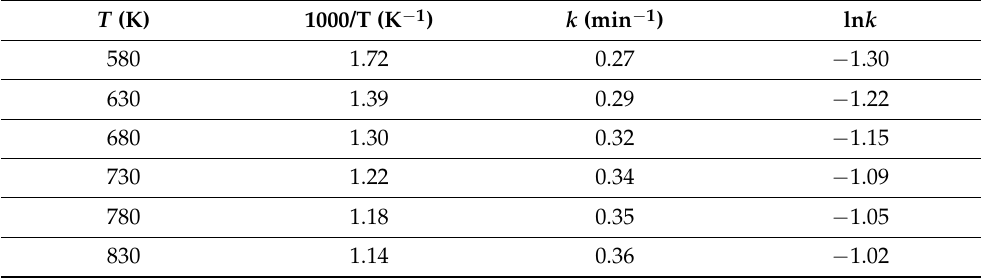
Table 2. Calculated kinetic values of the process of fluorination of rutile concentrate with elemental fluorine.